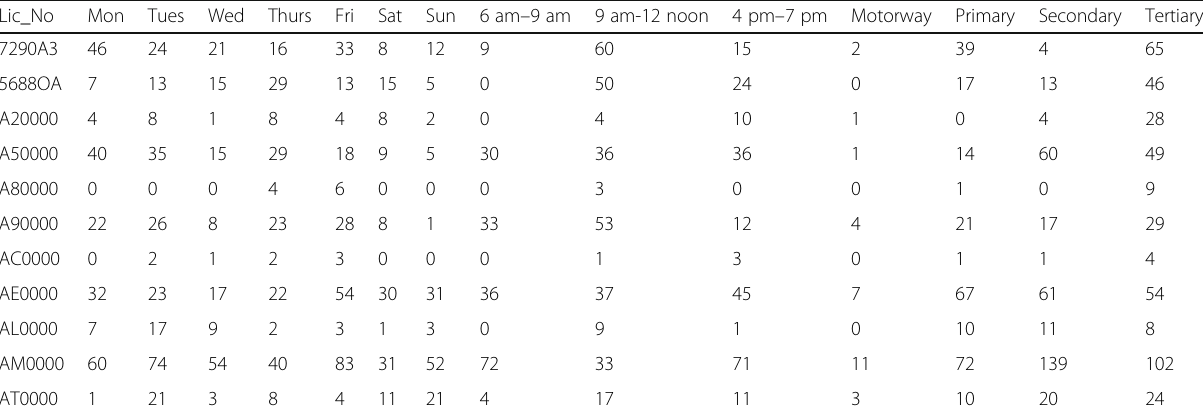
Table 6 A sample of variables used with their corresponding values